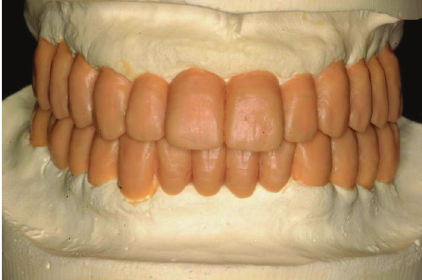
Figure 6: A first set of temporary restorations was developed. The wax-up included implant restorations and radiopaque landmarks embedded in the temporary crowns.